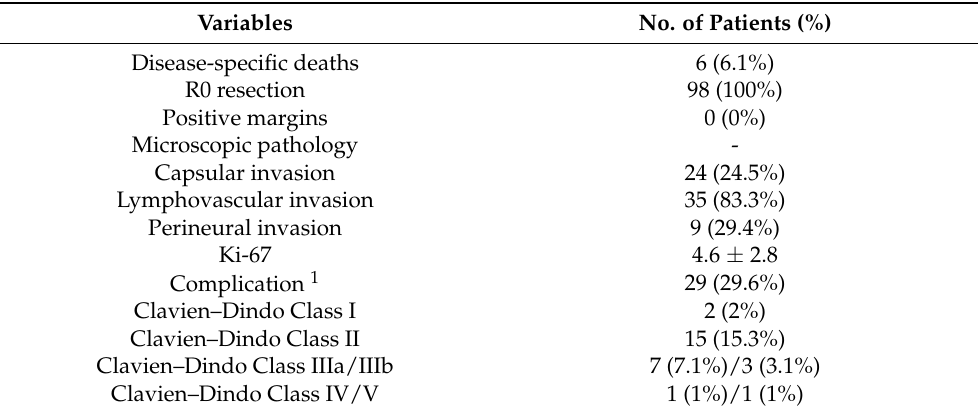
Table 3. Surgical outcomes of all 98